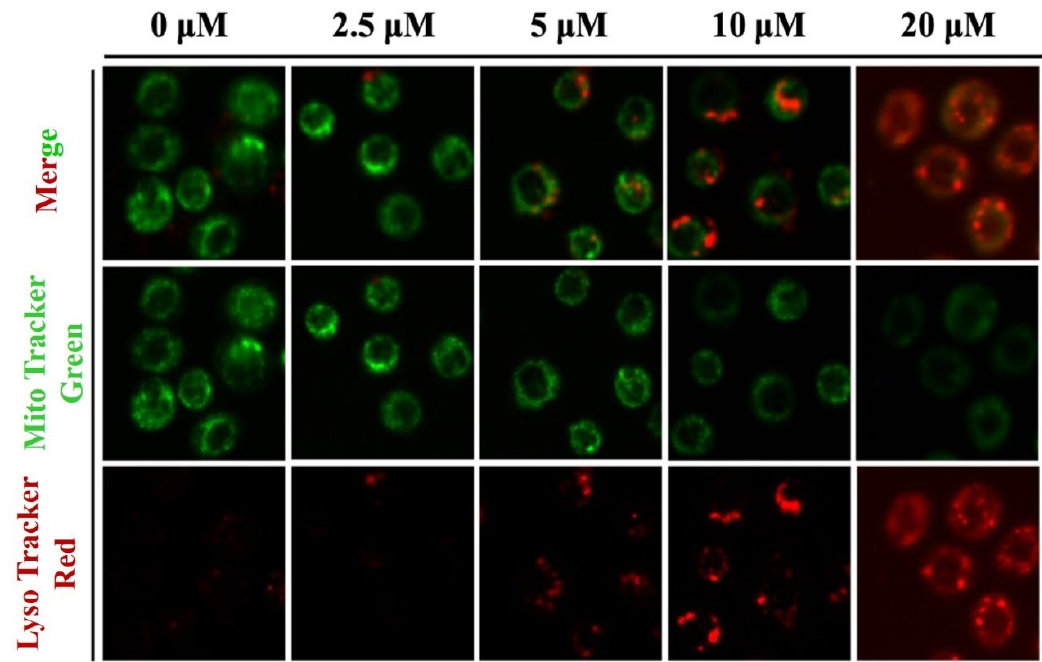
Figure 5. IVM induces mitophagy in RAW264.7 cells. After being treated with IVM for 6 h, cells were stained with MitoTracker Green and LysoTracker Red and observed with a fluorescence microscope (200×).